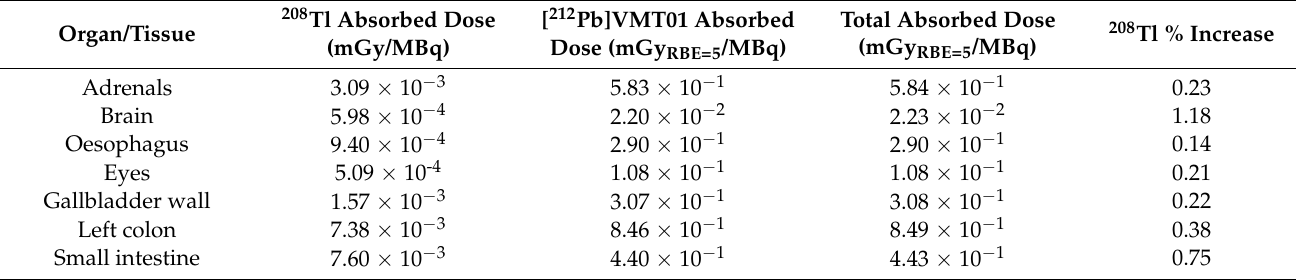
Table 4. Tissue absorbed dose estimates for human adult male for free 208 Tl in the injectate at